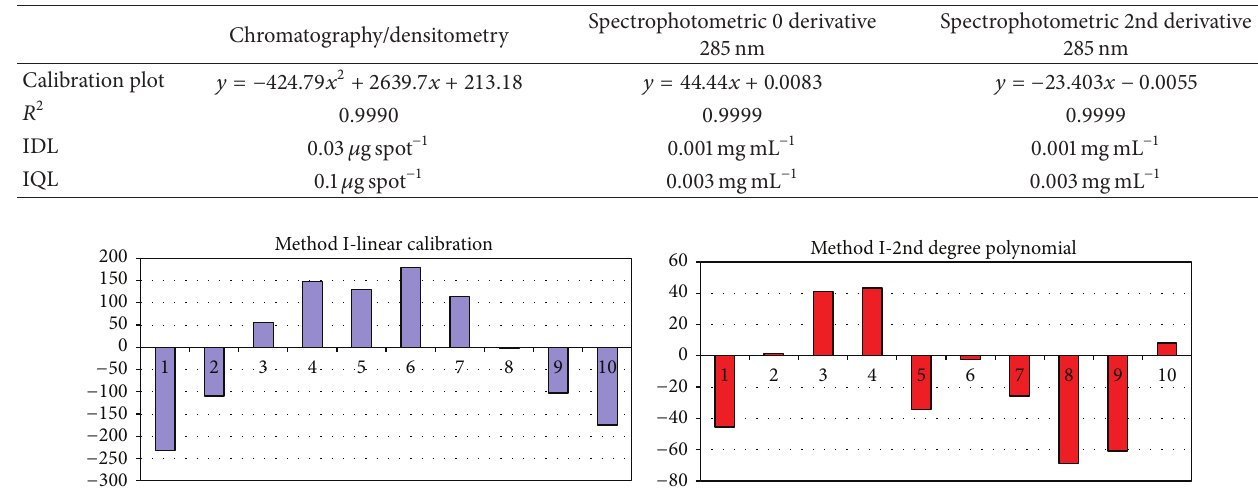
Table 1: Parameters of calibration plots.